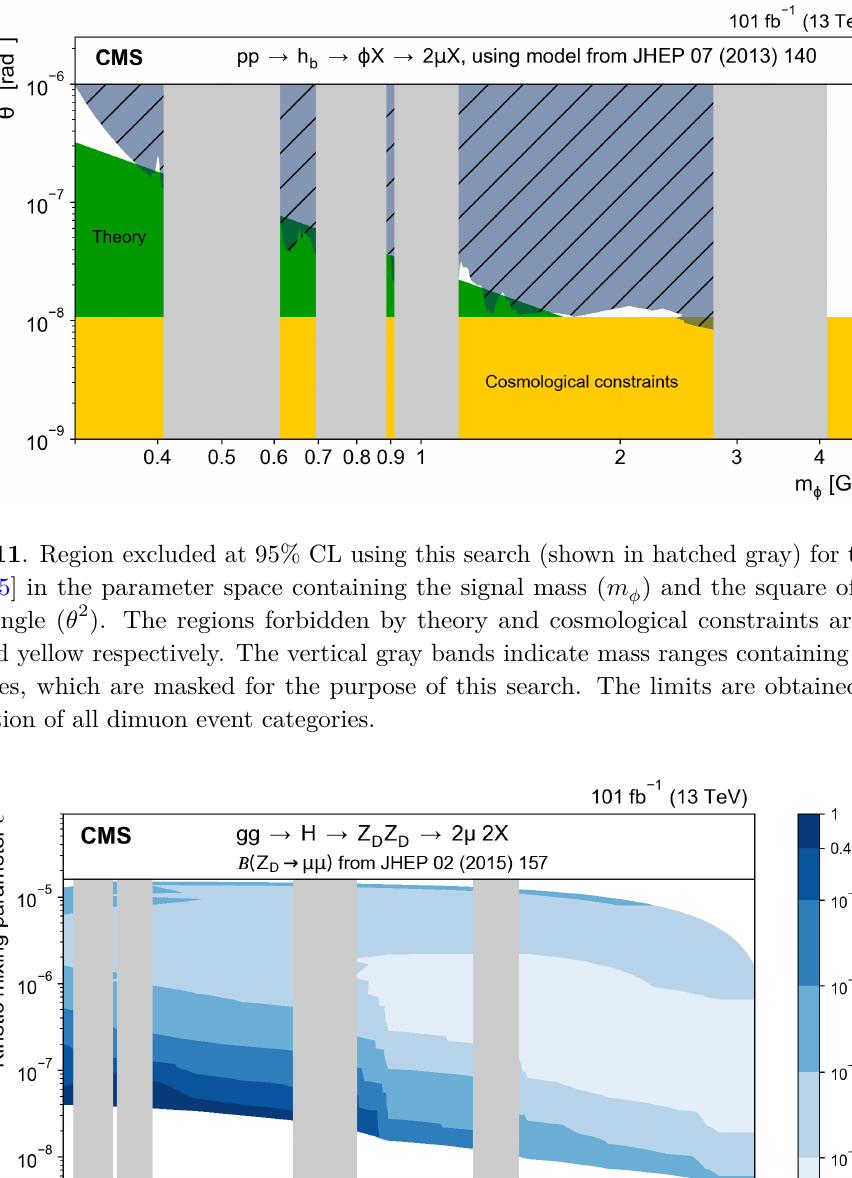
Figure 12 . Observed limits at 95% CL on the branching fraction B (H → Z the parameter space containing the signal mass ( m Z signal model assuming values of B (Z (cid:15) for the H → Z D D The vertical gray bands indicate mass ranges containing known SM resonances, which are masked for the purpose of this search. The white regions at the top (bottom) correspond to values of cτ Z D < 0 . 1 mm ( > 10 4 mm). The limits are obtained using the combination of all dimuon and 0 four-muon event